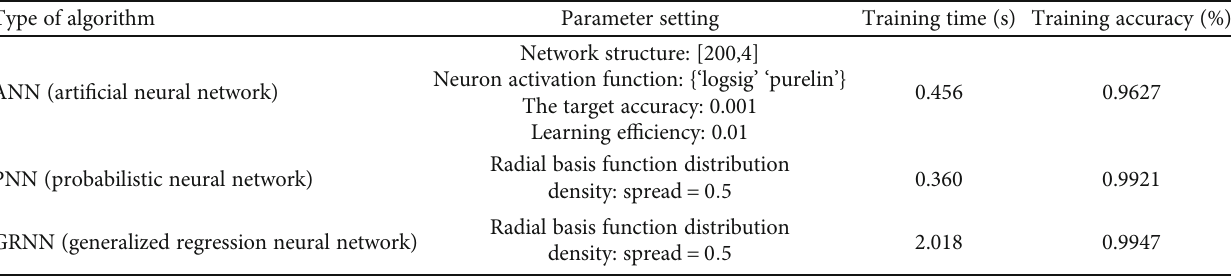
Table 4: Performance comparison of di ff erent